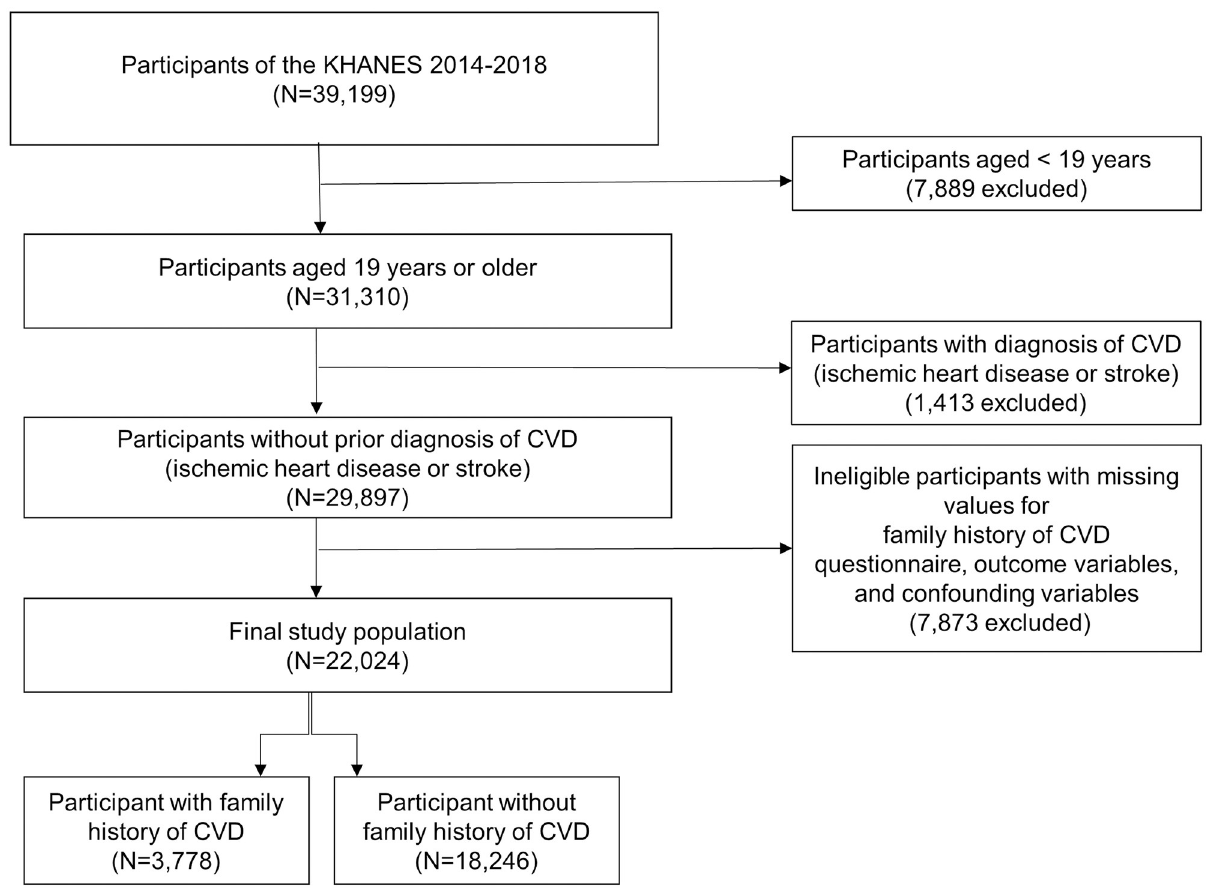
Fig 1. Flow chart of selection process of study population. KNHANES, Korea National Health and Nutrition Examination Survey; CVD, cardiovascular disease.